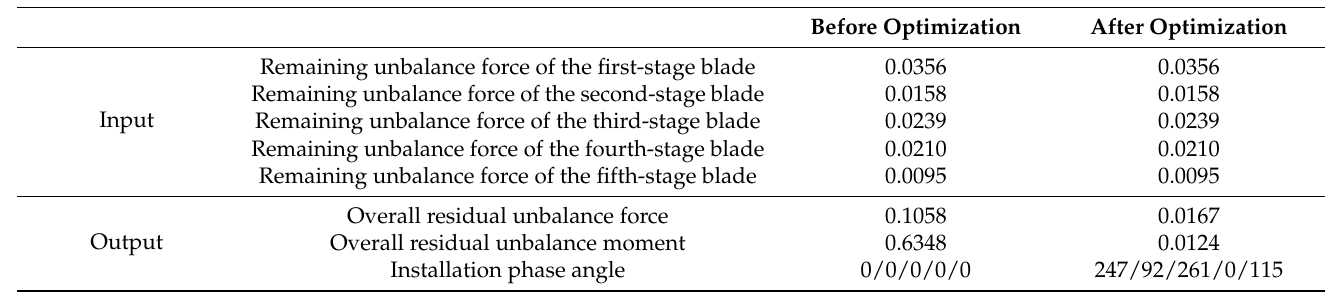
Figure 12. Assembly sequence of engine rotor disc blades at each stage: ( a ) First stage disc blade assembly sequence; ( b ) Assembly sequence of the second stage disc blade; ( c ) Assembly sequence of the third stage disc blade; ( d ) Assembly sequence of fourth stage disc blade. ( e ) Assembly sequence of fifth stage disc blade. Table 8. IHHO-optimized aero-engine rotor assembly phase